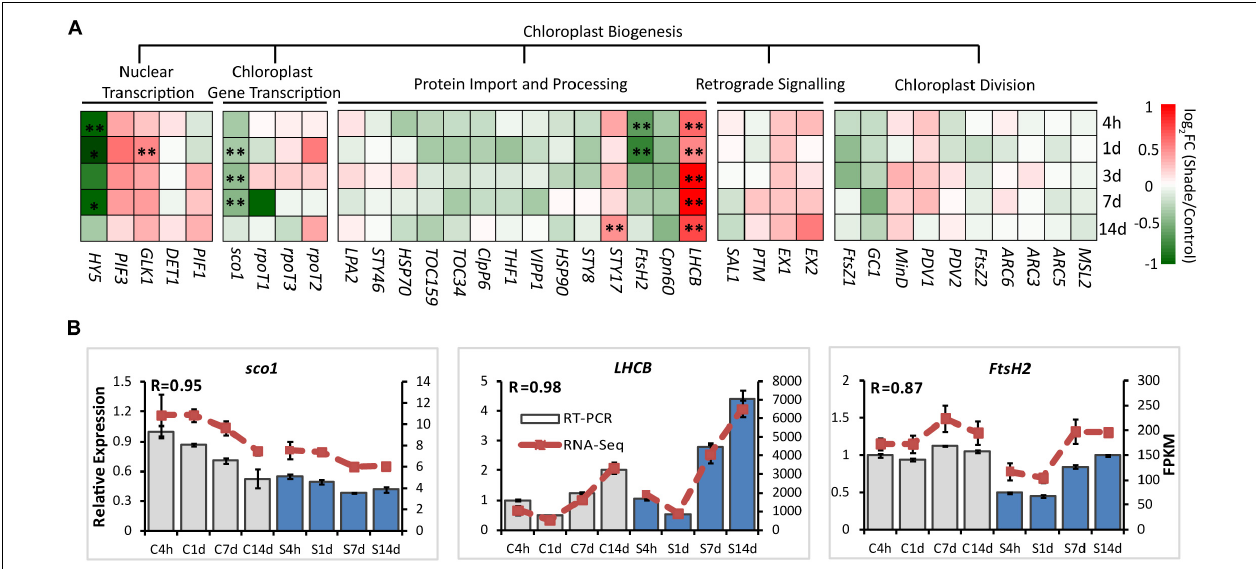
FIGURE 3 | Effect of shade on genes encoding key enzymes of the chlorophyll biosynthesis pathway. (A) Transcript abundance of 38 representative unigenes involved in the chlorophyll biosynthesis pathway generated from RNA-Seq analysis. Genes and TFs are classed into different subgroups according to their functions involved in the chloroplast biogenesis, including nuclear transcription, chloroplast gene transcription, protein import and processing, retrograde signaling and chloroplast division. (B) Transcript abundance of selected unigenes validated by the RT-PCR analysis. The column presents data generated from the RT-PCR analysis (gray column, data from the control treatment at four time points; blue column, data from the shade treatment at four time points). The line presents data generated from the RNA-Seq analysis. The transcript abundance in the control treatment at 4 h (C4h) was set at 1. R, the correlation factor between RT-PCR and RNA-Seq analysis for each gene/TF according to SPSS 13.0 software. 4h, 1d, 3d, 7d, and 14d indicate time points during the shade period. C, control treatment; S, shade treatment; FPKM, Fragment per kilobase of exon model per million mapped reads. Data shown are conducted of three independent biological replicates ( n = 3). ∗ Significant differences comparing the control treatment at each time point according to one-way ANOVA and a Fisher’s LSD test at the 5% level ( ∗ p ≤ 0.05, ∗∗ p ≤ 0.01; fold change ≥ 1.5). For abbreviations, see